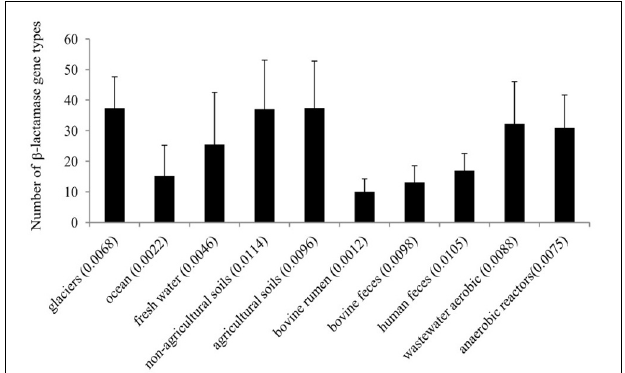
FIGURE 1 | Diversity of β -lactamases across different environments. The average β -lactamase relative abundance in percent of each environment (in brackets) is expressed as the ratio of β -lactamase hits per the total number metagenome